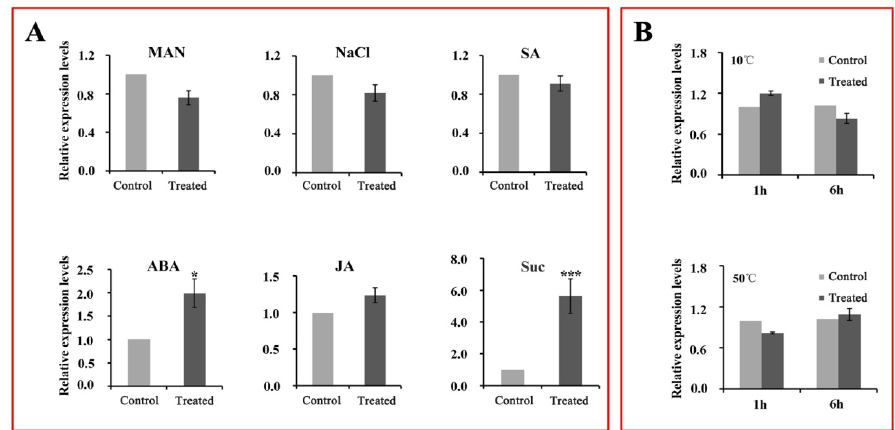
Figure 7. Effects of different abiotic treatments on the expression levels of CsWD40 in tea leaves. ( A ) The transcript levels of CsWD40 under mannitol (MAN), sodium chloride (NaCl), salicylic acid (SA), abscisic acid (ABA), jasmonic acid (JA), and sucrose (Suc) stresses. ( B ) The transcript levels of CsWD40 under different temperatures. The asterisks indicate the significant level ( n = 3, * p < 0.05, *** p < 0.001) based on a Tukey’s honestly significant difference test.